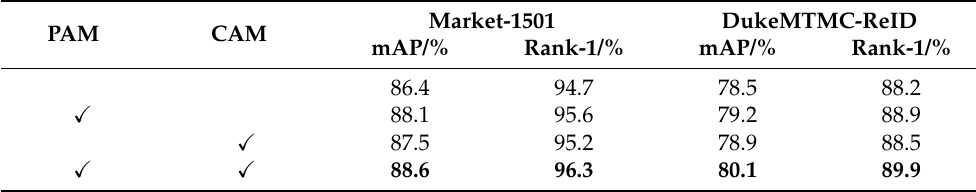
Table 4. Comparative experiment of attention